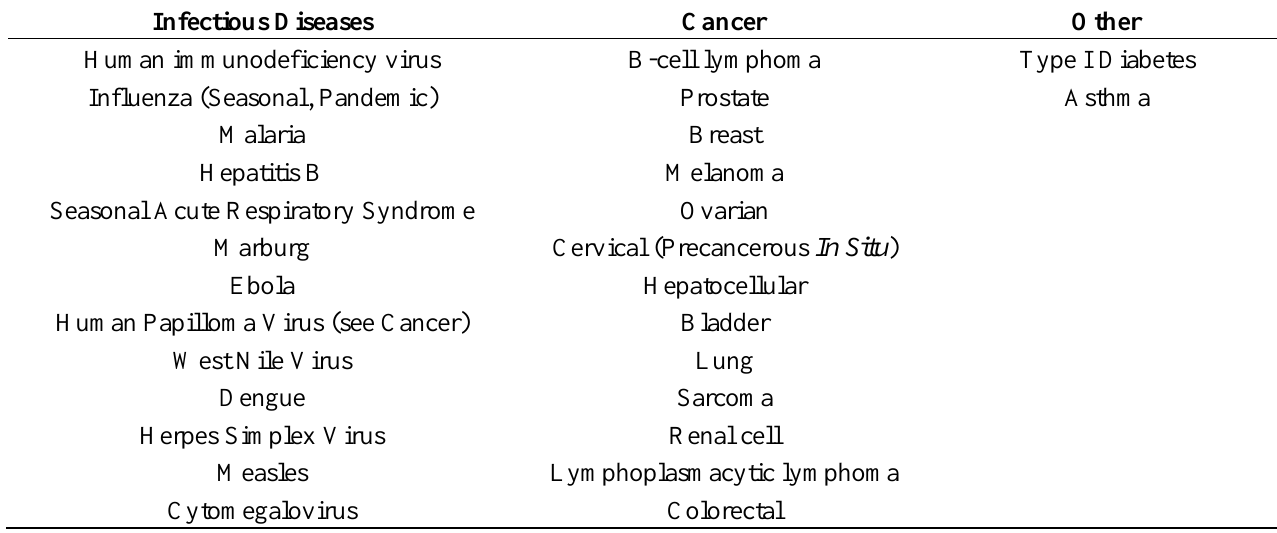
Table 1. Diseases for which DNA vaccines have entered clinical